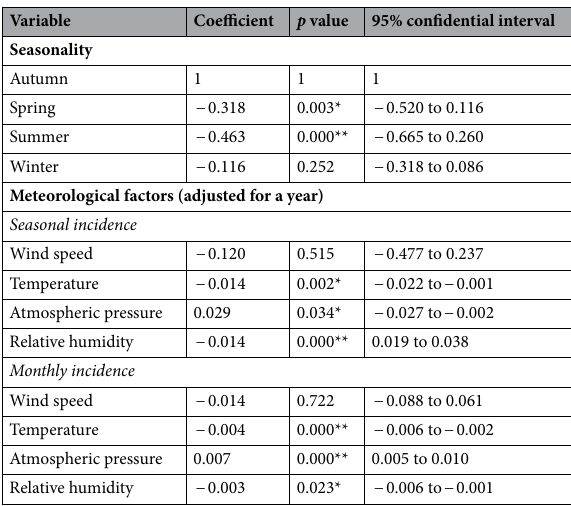
Table 2. The seasonality and the association between the seasonal and monthly incidence of Bell’s palsy and meteorological factors. Multivariate linear regression analysis. * p < 0.05 ** p < 0.001.